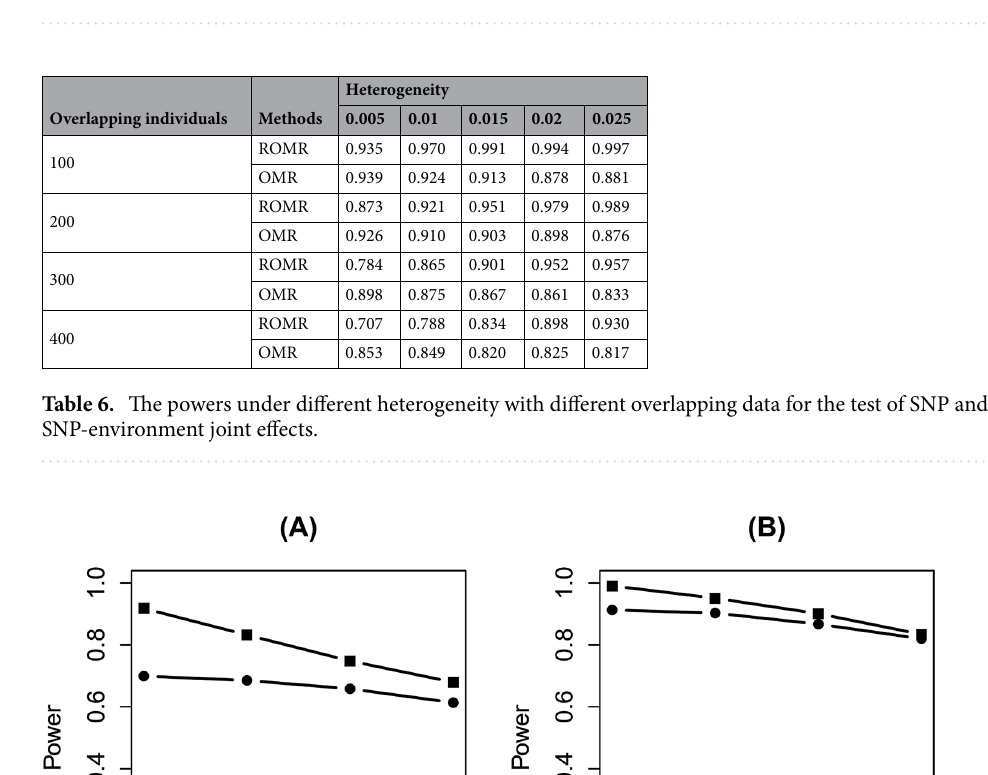
Table 5. The powers under different heterogeneity with different overlapping data for the test of SNP- environment interaction.